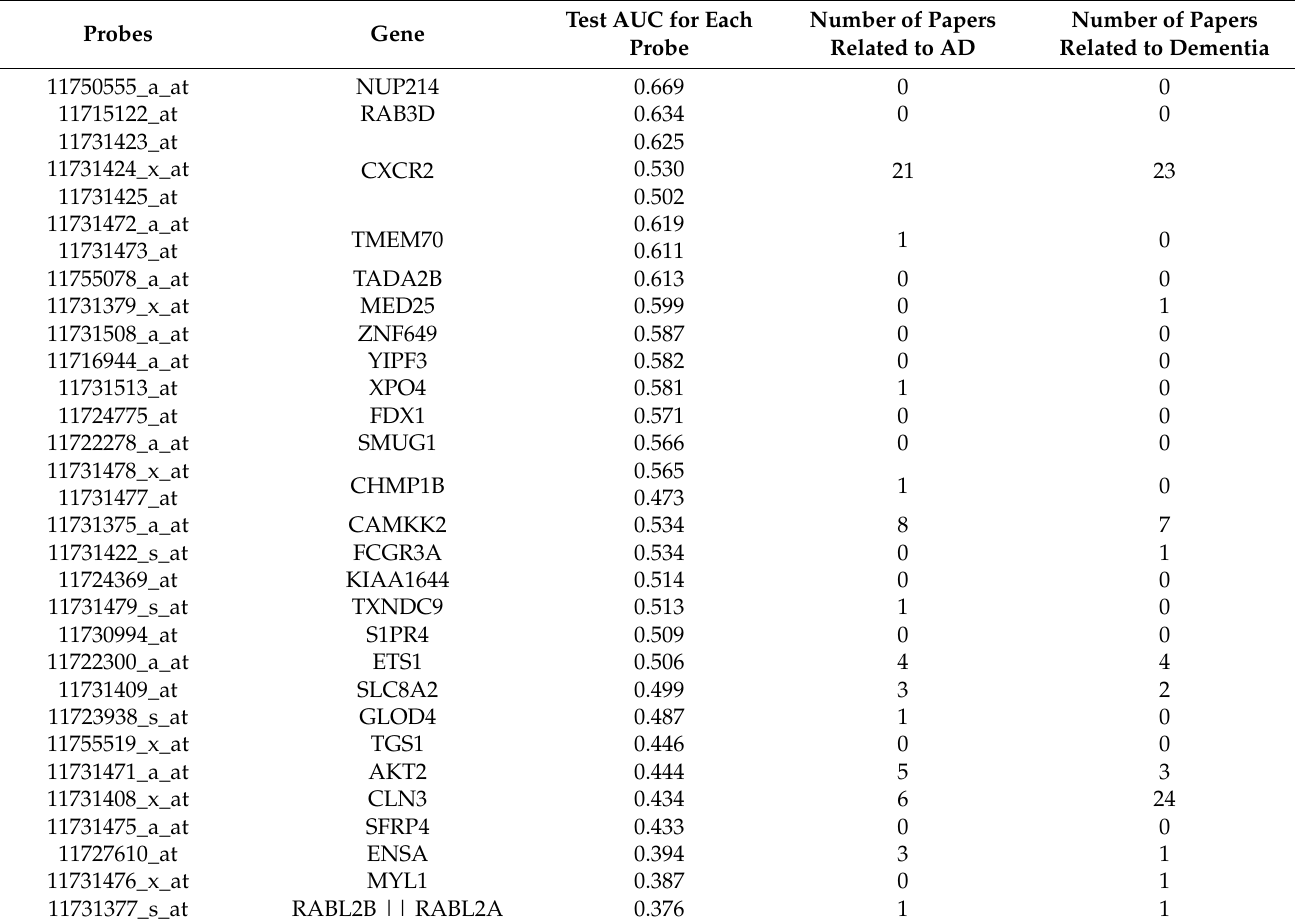
Table 2. Co-occurrence analysis of the identified 31 probes (29 genes) and AD/dementia in published literature and corresponding test